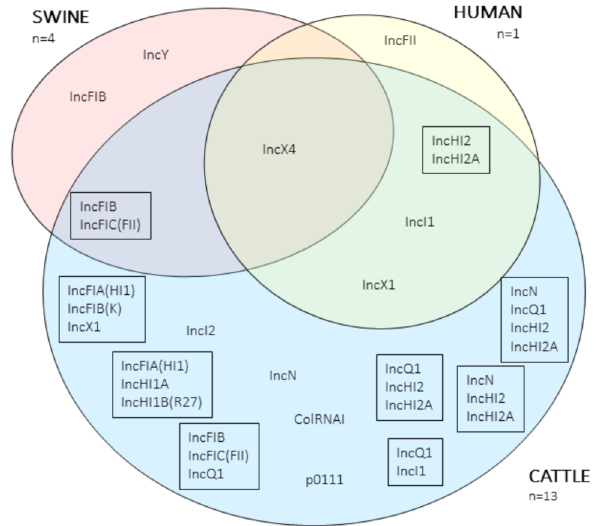
Figure 2. Venn diagram representing the replicons of the antimicrobial resistance gene (ARGs) plasmids. Replicons inside a box indicate a combination of replicons within the same